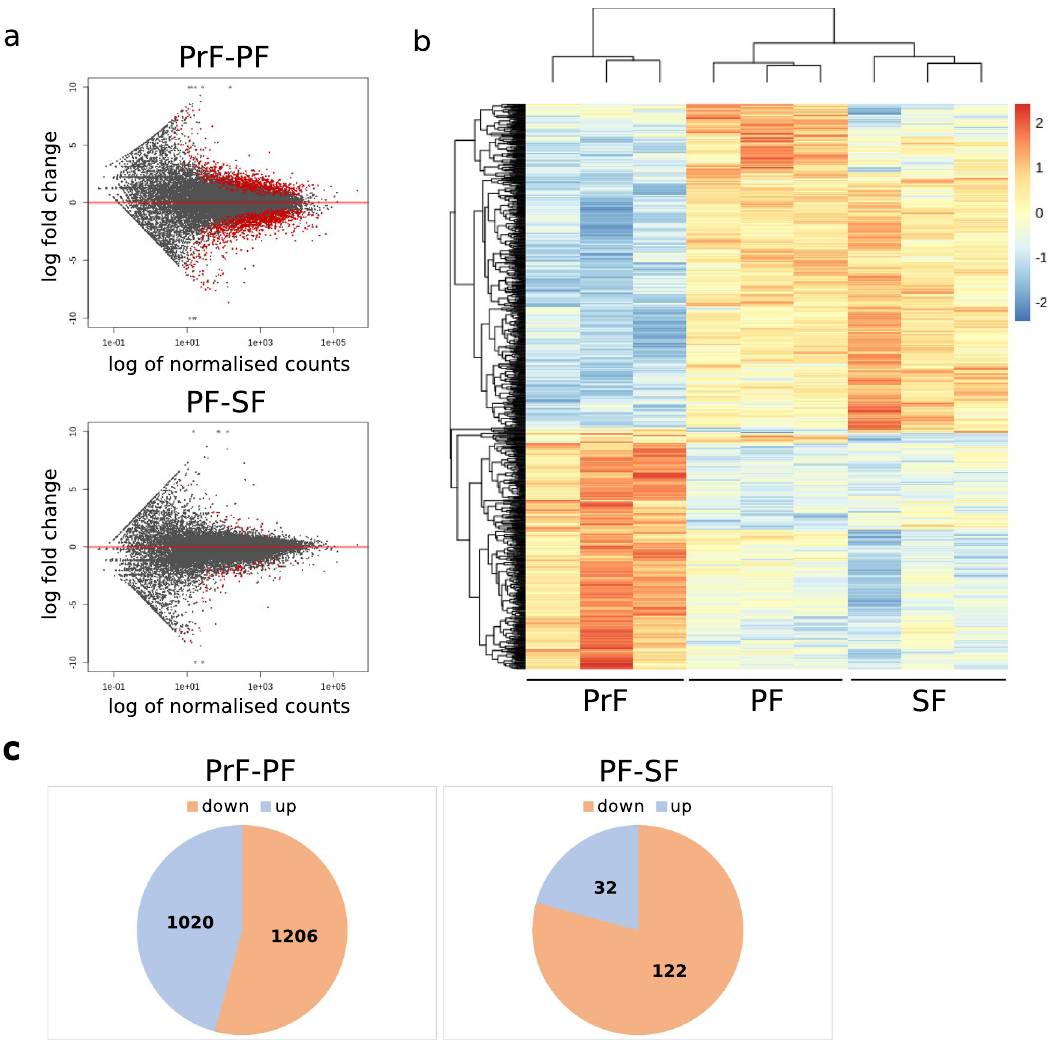
Figure 2. Differential gene expression during preantral ovarian folliculogenesis in domestic cat. (a) The estimated number of DEGs between ovarian follicle contrasts: primordial versus primary and primary versus secondary with an adjusted P value of < 0.05 and log 2 fold-change ≥ 1 were visualised utilising MA plots whereby, non-significant genes (values not satisfying the P value and log 2 fold-change threshold) are shown in black and significant genes (values satisfying the P value and log 2 fold-change threshold) are shown in red, log 2 fold- change is mapped to y and the normalised mean is mapped to x (transformed to log 10 scale); (b) Patterns of gene expression changes are shown on a heatmap with an adjusted P value of < 0.01 and log 2 fold-change ≥ 1. The colour red represents relative increase in expression, blue represents relative decrease, and pale orange (in the middle of the colour scale) represents no change. The columns are labelled with follicle type, respectively; (c) Pie charts summarise the estimated number of DEGs between the primordial versus primary and primary versus secondary contrasts with an adjusted P value of < 0.05 and log 2 fold-change ≥ (Supplementary Data S2). Significantly enriched terms included “extracellular region part” ( Q = 2.10E−07), “focal adhesion” ( Q = 5.30E−05), “movement of cell or subcellular component” ( Q = 6.70E−04), and “cell morphogen- esis” ( Q = 3.80E−03). The KO terms such as, “ECM receptor interaction” ( Q = 1.60E−06) and “focal adhesion” ( Q = 1.80E−03) were significantly enriched also. Other enriched terms and pathways were involved in “cel- lular response to growth factor stimulus” and the “phosphatidylinositol 3-kinase (PI3K)-Akt/Protein Kinase B (Akt)” and “transmembrane receptor protein serine/threonine kinase” signalling pathways (Table 1). Addition- ally, “platelet derived growth factor”, “integrin-mediated”, and “transforming growth factor (TGF)-β” signalling were observed during the PrF-PF transition (Supplementary Data S3). Interestingly, “axonemal dynein complex assembly” was identified in Annotation Cluster 32 and was coupled with “ciliary plasm” and “axoneme cellular components” (Supplementary Data S2). Functional annotation clustering of the 154 PF-SF DEGs resulted in 128 DAVID IDs in 27 clusters (Sup- plementary Data S2). Identified terms included “reproductive process”, “cellular response to chemical stimu- lus”, “ovulation cycle process”, and “epithelial cell proliferation” (Table 2). The KOs included terms involved in “focal adhesion” and “inositol phosphate metabolism” along with “sphingolipid”, “phosphatidylinositol”, “thyroid